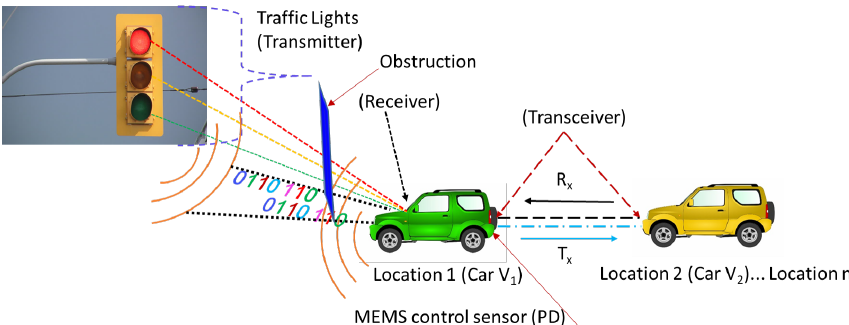
Figure 1. An outdoor configuration of several vehicles